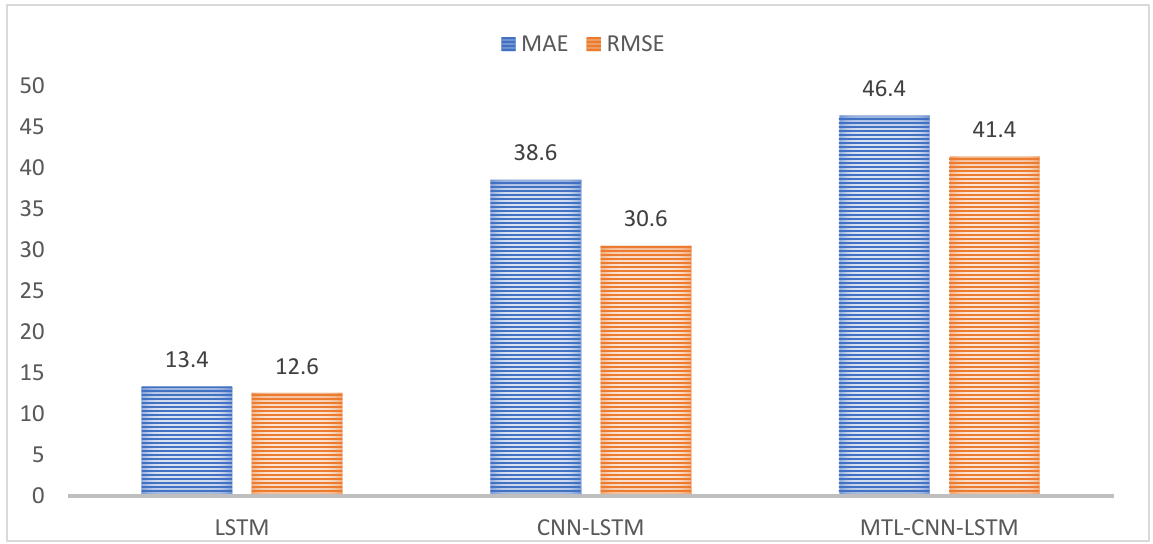
Figure 6. Schematic diagram of model performance improvement efficiency comparison.